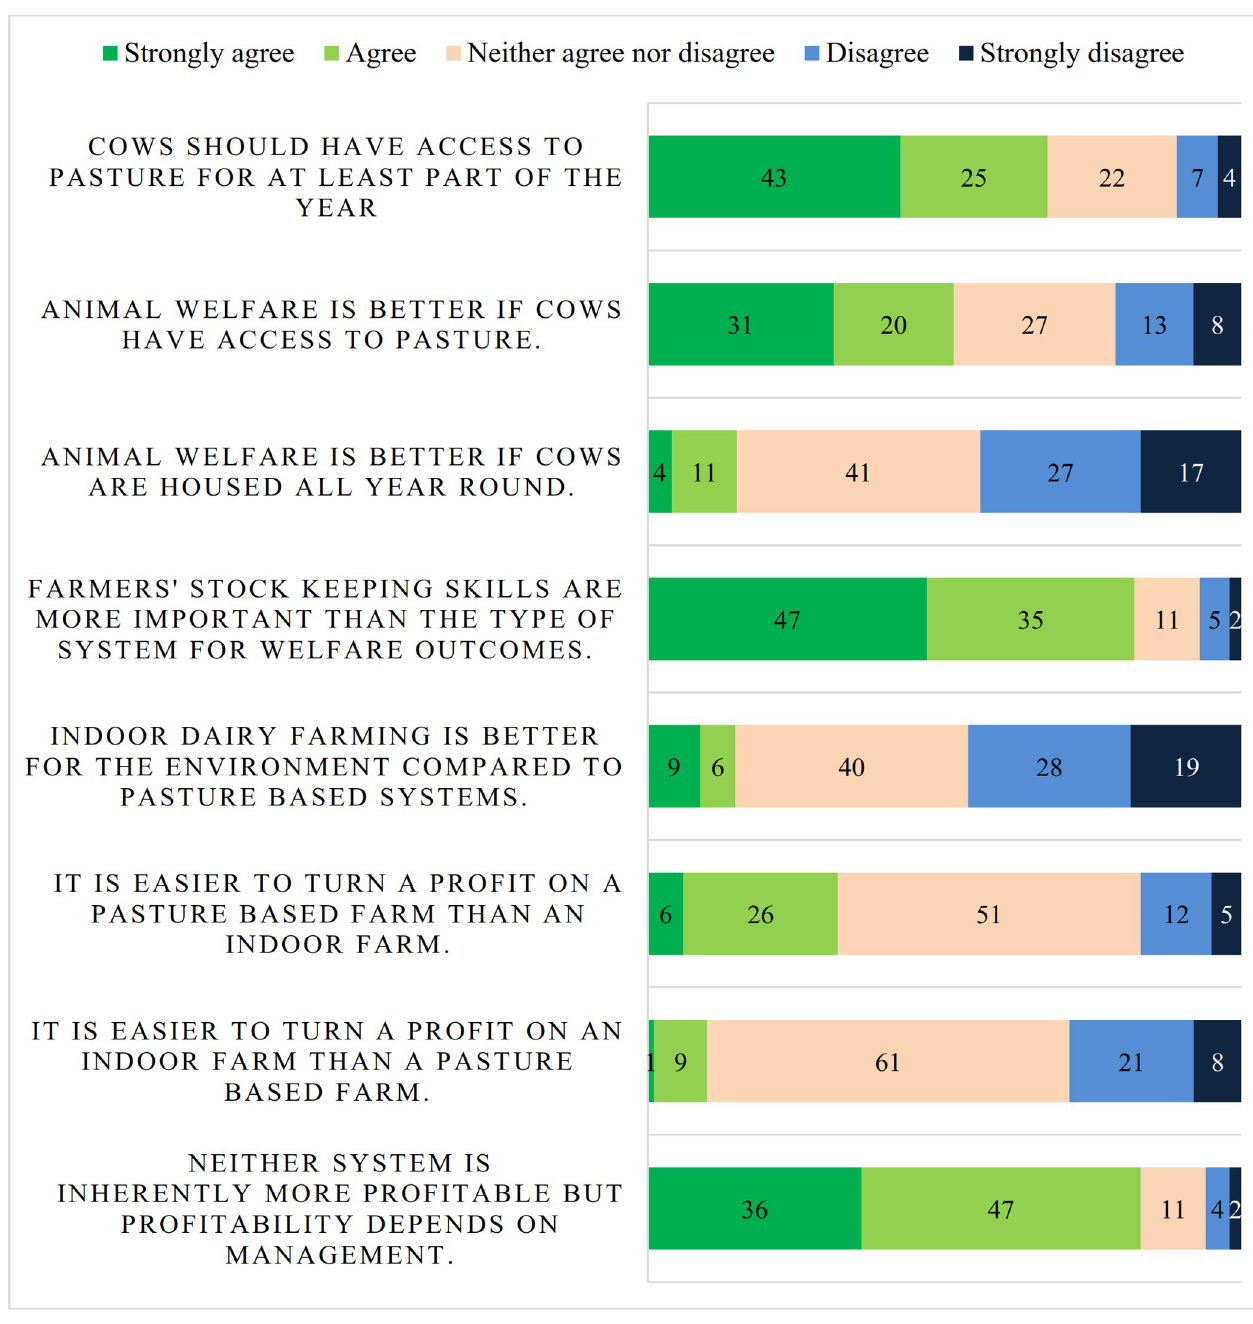
Fig 2. Attitudes towards production